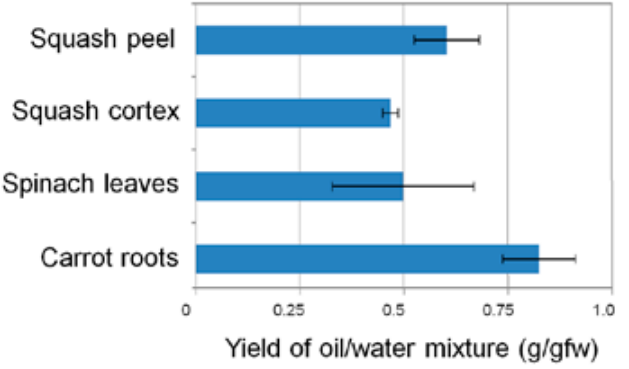
Fig. 3 - Yield of oil/water mixture extracted from vegetables using DME as solvent. Mixture of oil and water containing pigments from vegetables are